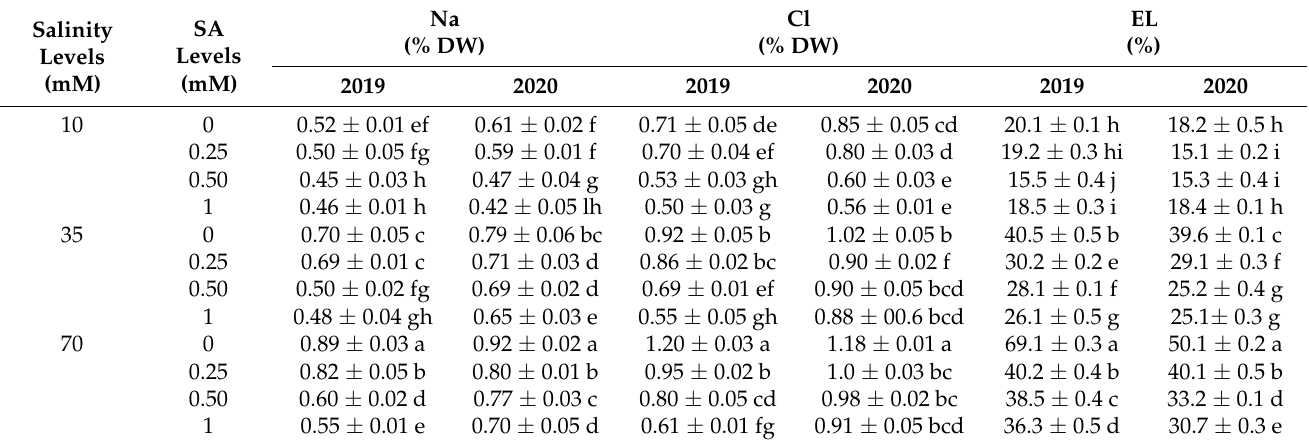
Table 4. Means of leaf sodium content (Na), leaf chloride content (Cl), and electrolyte leakage (EL) of pomegranate plants in response to foliar salicylic acid (SA) treatments under salinity stress conditions.